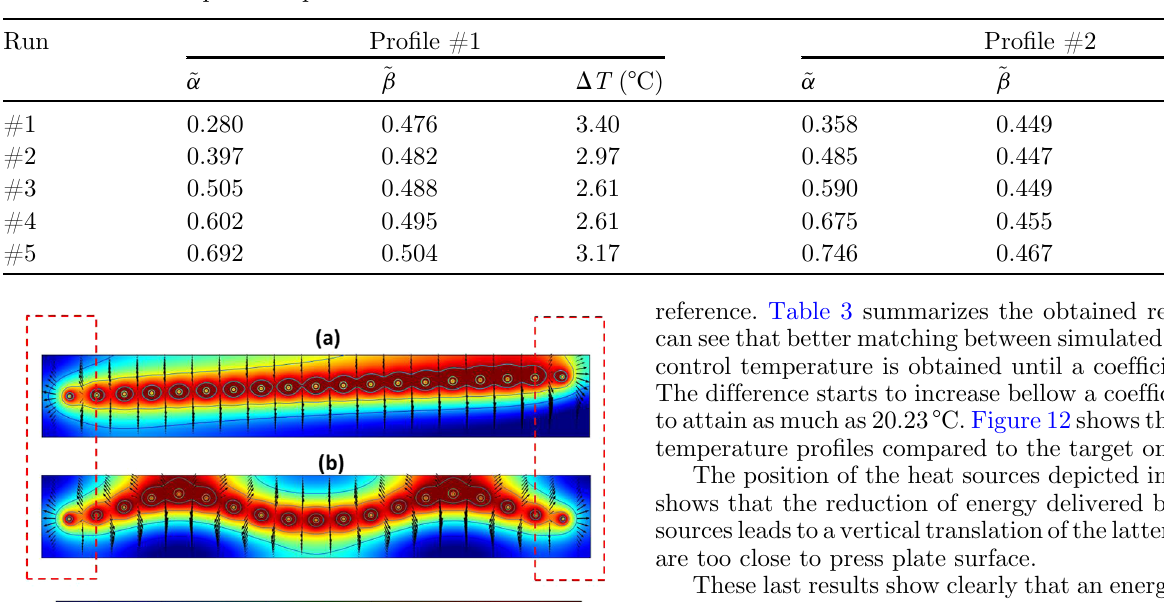
Fig. 9. Comparison between absolute temperature differences obtained for the tested pro fi les (a) pro fi le #1 and (b) pro fi le #2. The bars from left to right correspond to run #1, #3 and #5 respectively. ~ b Table 2. Identi fi ed values ~ a and of the parametric function with the corresponding minimal objective function for the tested control temperature pro fi